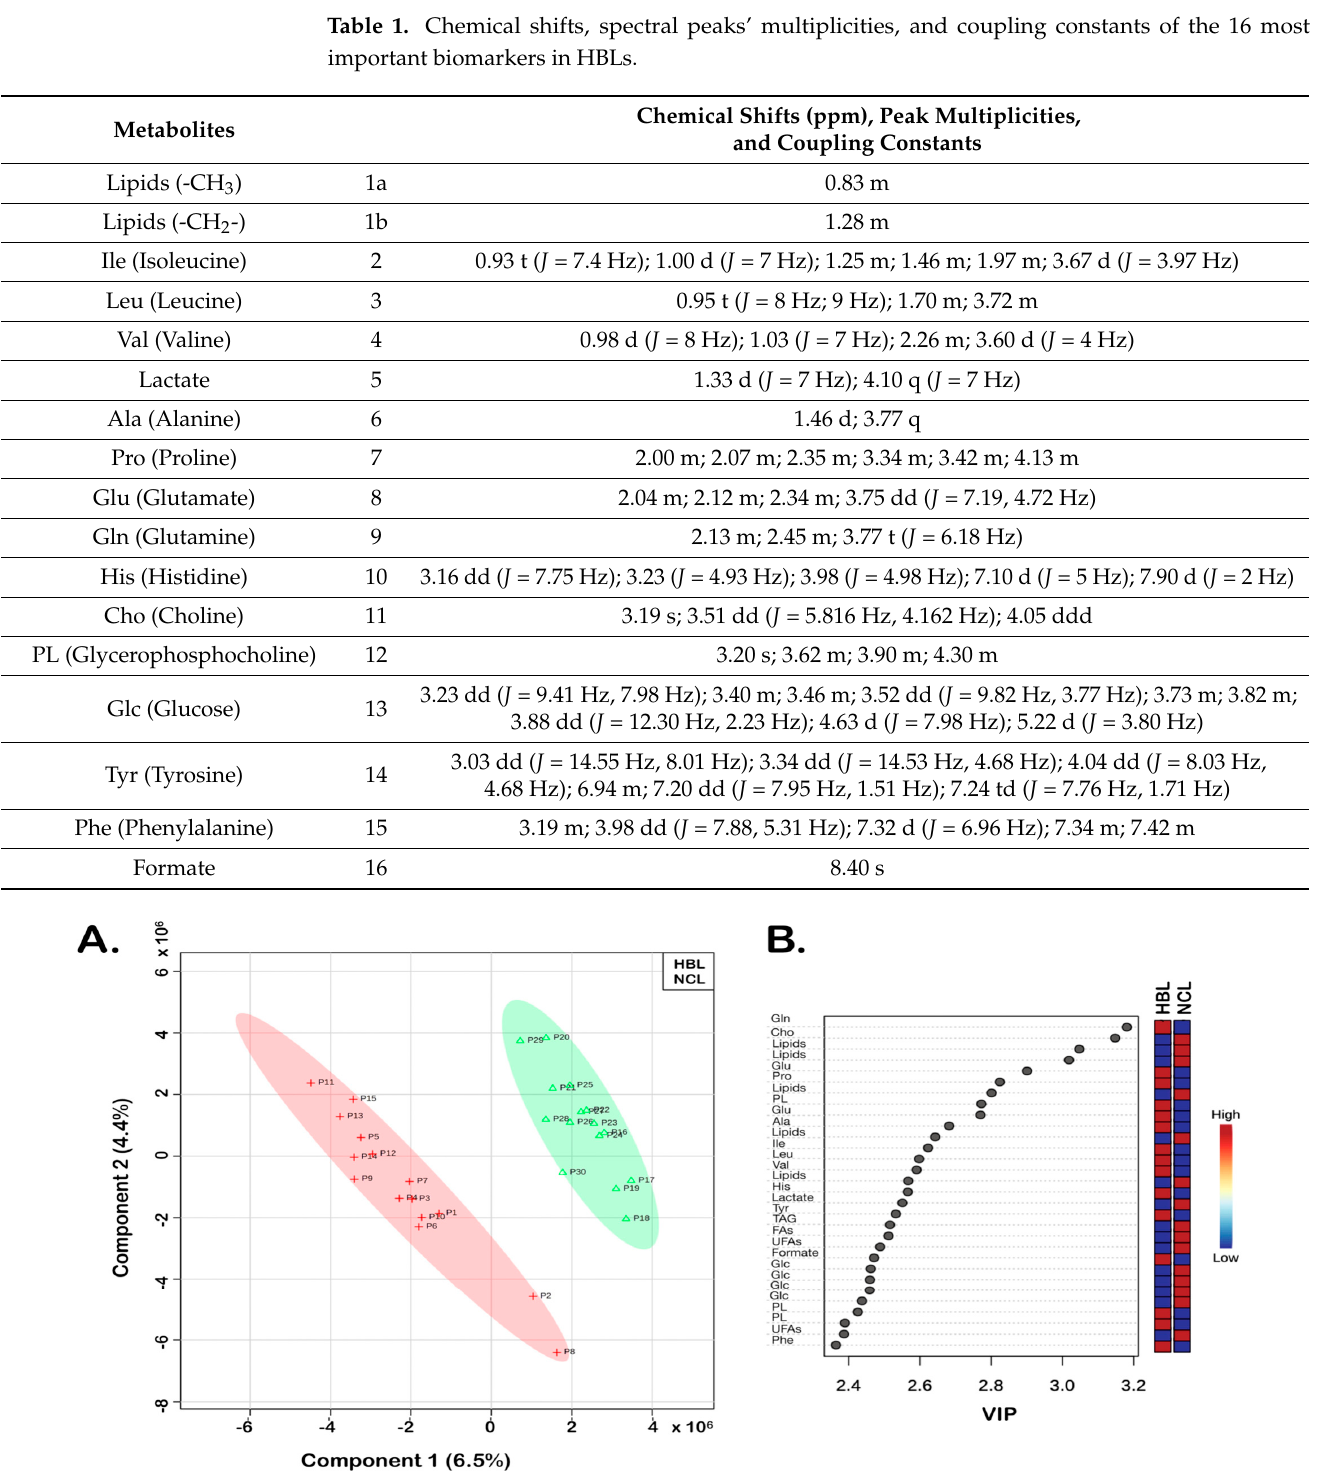
Figure 2. HBL vs. NCL. PLS-DA of the HR-MAS 1 H-NMR CPMG data: ( A ) 2D score plot shows 15 HBL and 15 NCL samples; statistical parameters were as follows: accuracy (0.68), R 2 (0.77), and Q 2 (0.39). ( B ) Variable importance in projection (VIP) scores greater than 2.35 were assigned to important metabolites 1–16, as summarized in Table 1, which are discriminatory for HBL vs. NCL in the PLS-DA model. HBL tissue samples are shown with red crosses and the non-cancer liver tissue samples (NCL) are shown in green